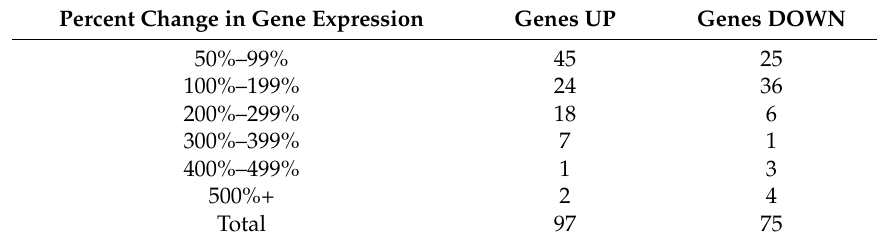
Table 27. Distribution of Genes Affected by GHK and Associated with Sensory Nerve Cells.